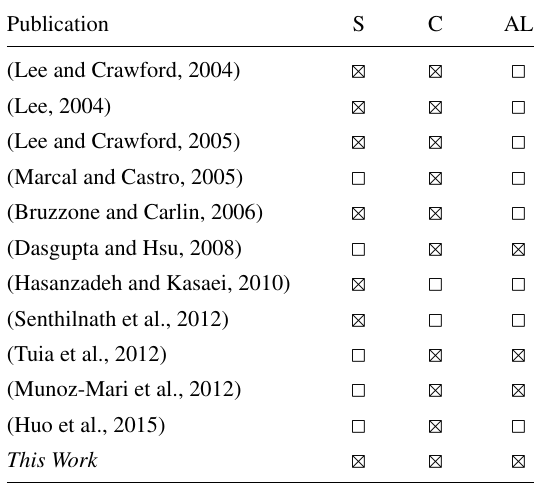
Table 1. Overview of related work in comparison to the three main stages of the presented method: segmentation (S), clustering (C), and active learning